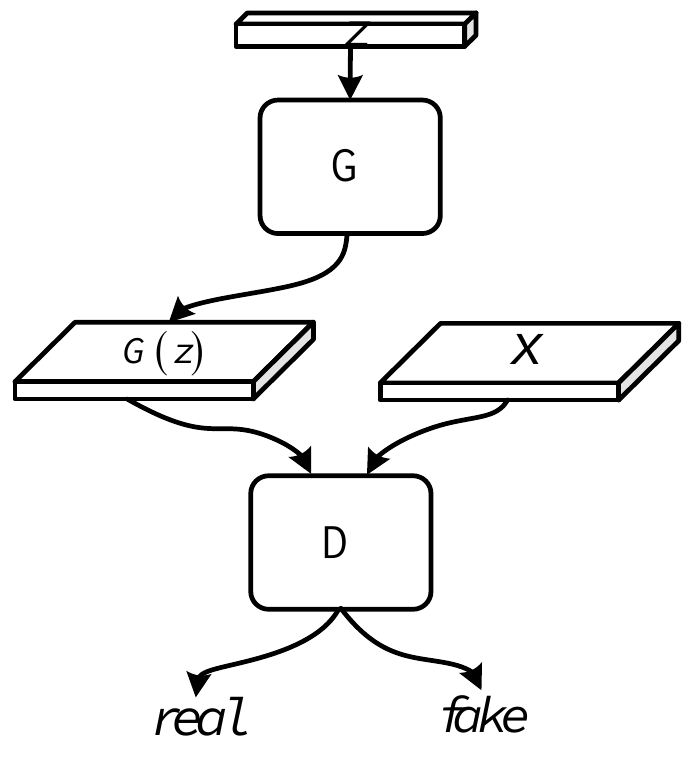
Figure 2. Generative Adversarial Network Structure Diagram .